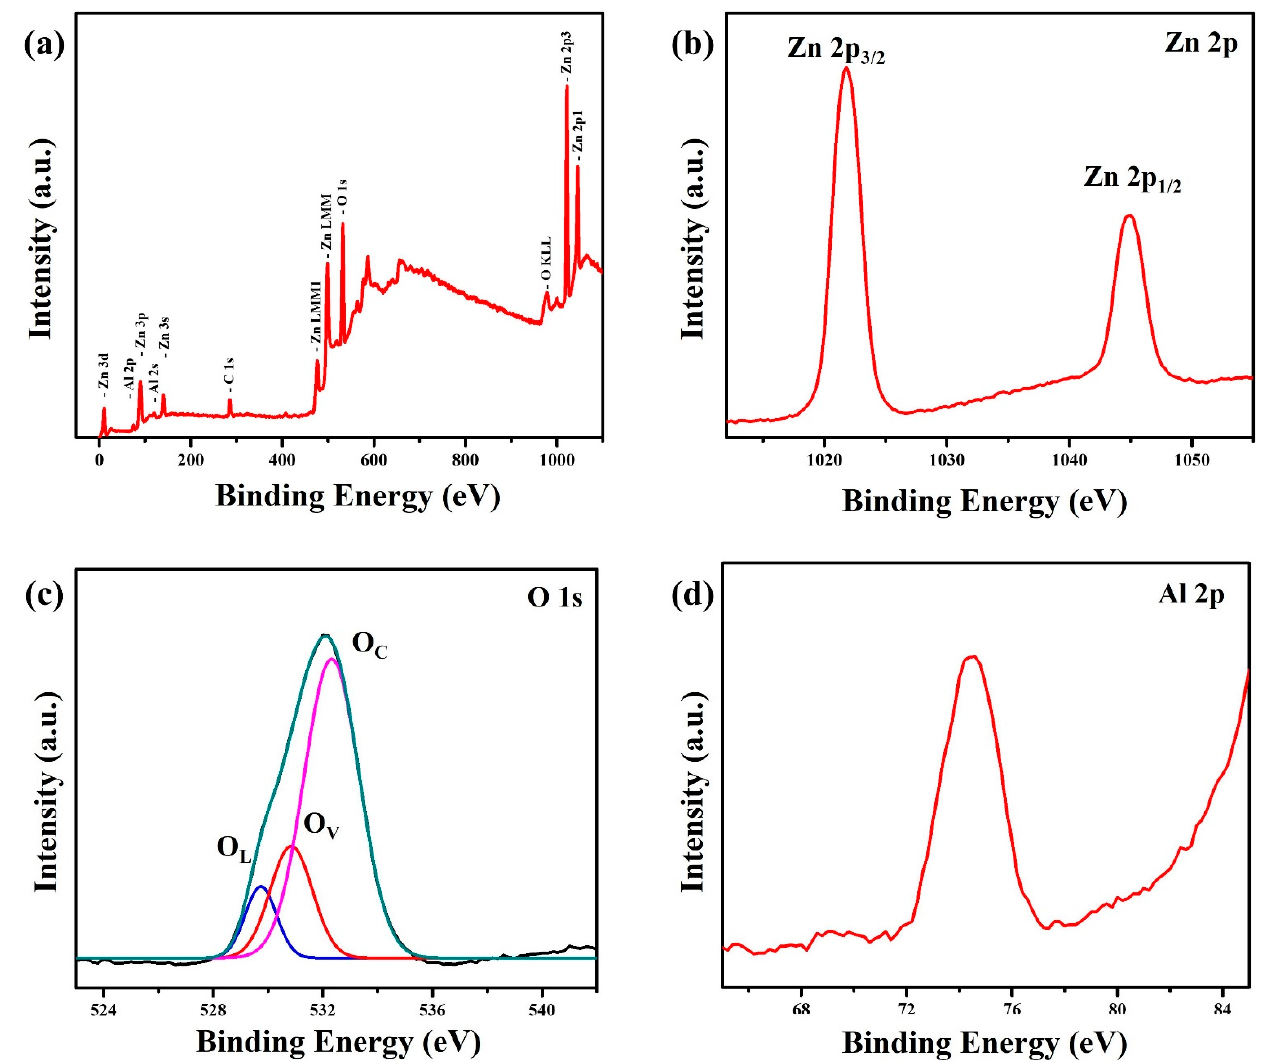
Figure 7. XPS spectra of the ZnO nanowalls: ( a ) survey spectrum, ( b ) Zn 2p, ( c ) O 1s, and ( d ) Al 2p.